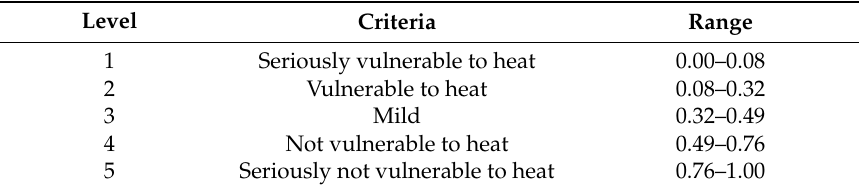
Table 1. Level of thermal vulnerability index (TVI).